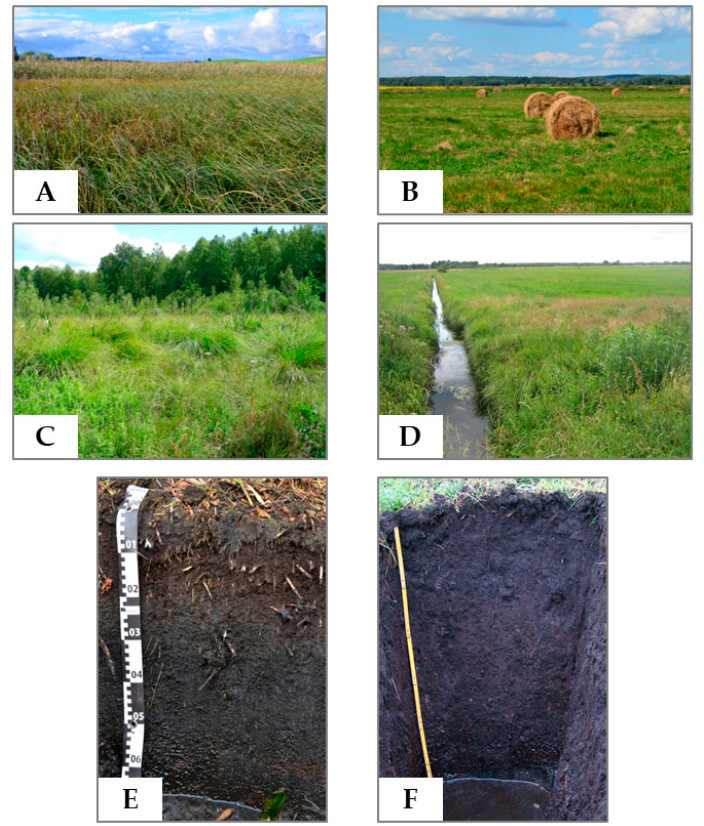
Figure 1. Differences between natural and drained peatlands used for agriculture: ( A )—natural fen peatland covered by peat-forming vegetation (rushes of sedge and reed); ( B )—meadow on drained fen peatland; ( C )—sedge rushes and alder forest on natural low peatland; ( D )—drainage ditches on peatland use as meadow; ( E )—profile of undrained peat soil (top layer—acrotelm abundant in roots); ( F )—profile of drained peat soil (uppermost mursh layer).